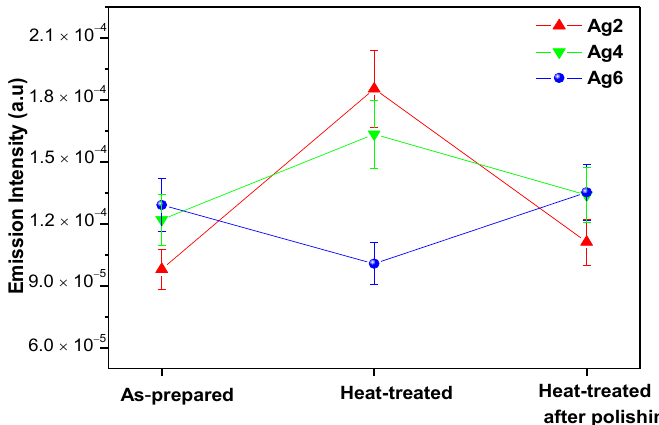
Figure 9. Variation of 1.53 μm band peak emission intensity.